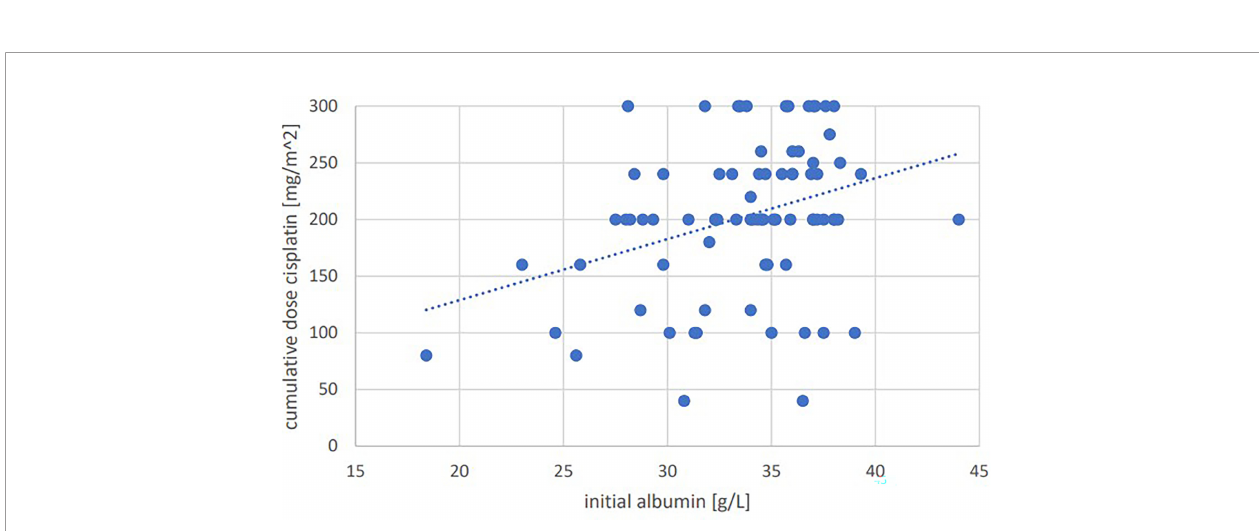
FIGURE 4 | Bivariate correlation analysis of initial albumin value [g/L] with fi nal cumulative total dose of cisplatin achieved [mg/m^2]: p=0.002, Pearson ’ s r=0.337; individual values as points, dashed linear trend